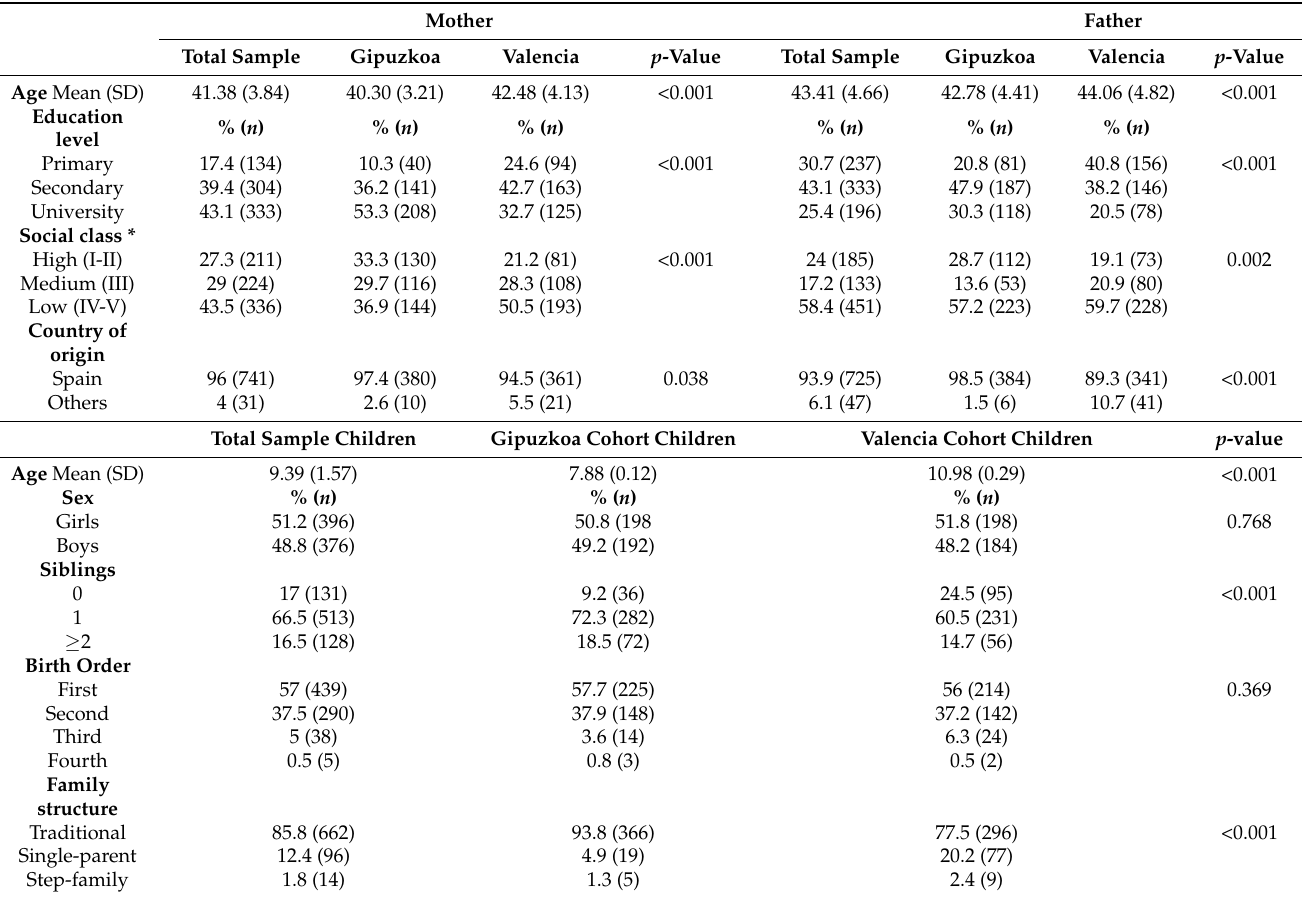
Table 1. Socio-demographic characteristics of the families participating in the study. Gipuzkoa and Valencia cohorts of the INMA